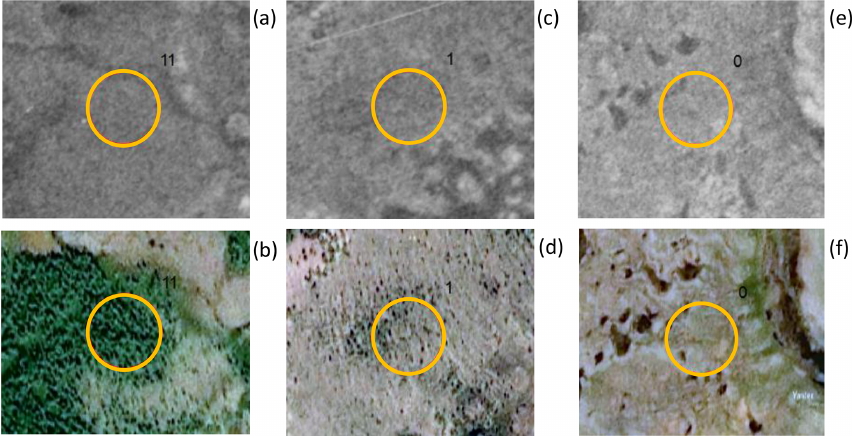
Figure 3. Examples of samples used for the visual analysis of vegetation dynamics. Diameter of each sample is 100m. The images are taken from Corona and SPOT-6 and SPOT-7 mosaic (©Yandex.Maps). (a, b) shift to forest, (c, d) shift to woodlands, (e, f) no